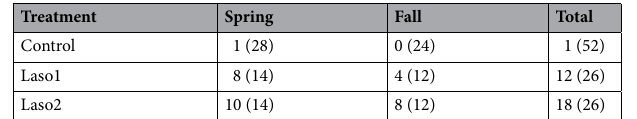
Table 1. Number of hoary bats ( Lasiurus cinereus ) captured during different conspecific social call playback treatments and control during spring and fall (number of trials in parentheses).